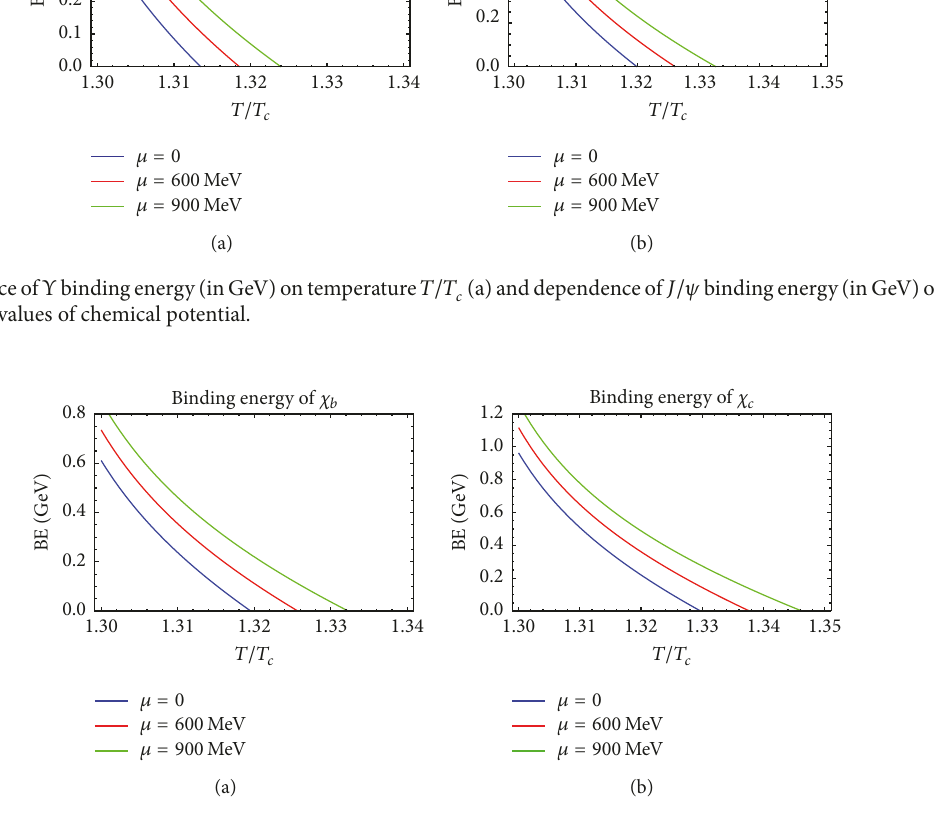
Figure 5: Dependence of 𝜒 𝑏 binding energy (in GeV) on temperature 𝑇/𝑇 𝑐 (a) and dependence of 𝜒 𝑐 binding energy (in GeV) on temperature 𝑇/𝑇 𝑐 (b) at different values of chemical